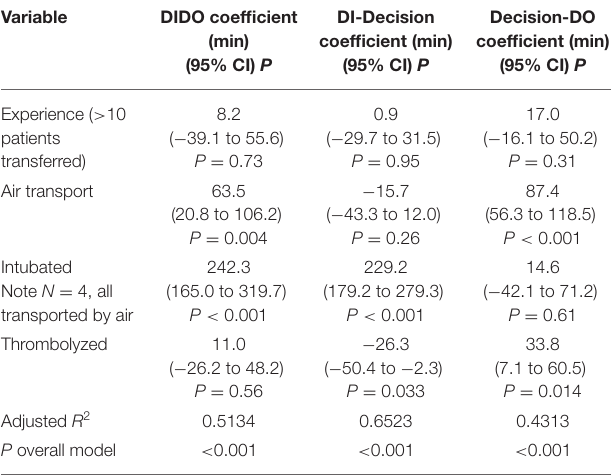
TABLE 3 | Effects of selected variables on components of DIDO in adjusted